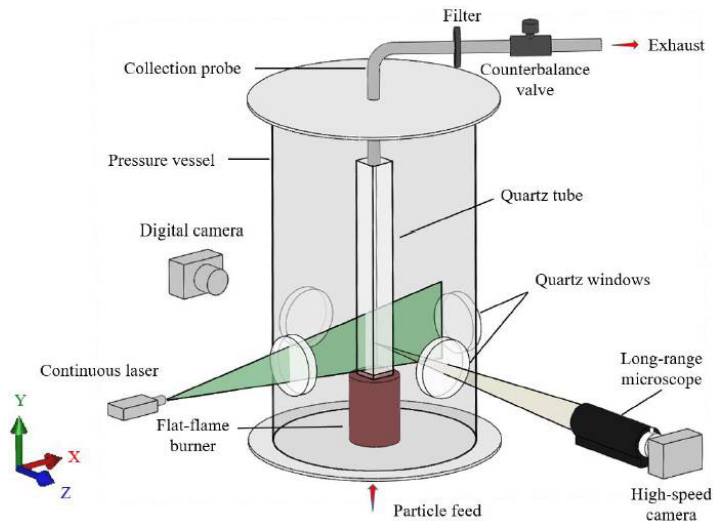
Figure 1. Schematics of the reactor. The particle-tracking image pyrometer (PTIP) system proposed in this work was composed of a high-resolution high-speed camera (FASTCAM Mini AX200), a digital SLR camera (Nikon D70), and a 532 nm continuous laser, as shown in Figure 2. Based on the continuous particle images taken by high-speed cameras and the existing pulverized coal identification and tracking methods [24], it was possible to identify and track the effectively burned particles.